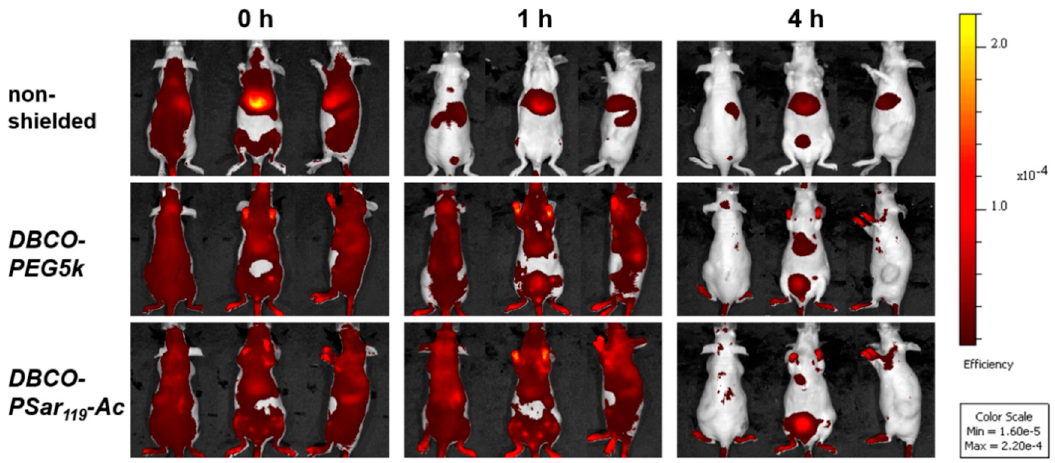
Figure 4. Biodistribution of T-1N 3 siRNA formulations (50 µg siRNA; 50% Cy7-labeled) in NMRI-nude mice bearing Neuro2a tumors after i.v. administration. NIR fluorescence bioimages show formulations with 1 eq DBCO-PEG5k , 1 eq acetylated DBCO-pSar 119 - Ac or HBG buffer (non-shielded). Experiments were performed with two mice per group for time points until 60 min and one mouse per group for later time points; a representative mouse of each group is shown. Mice are presented in the dorsal, ventral and lateral view.